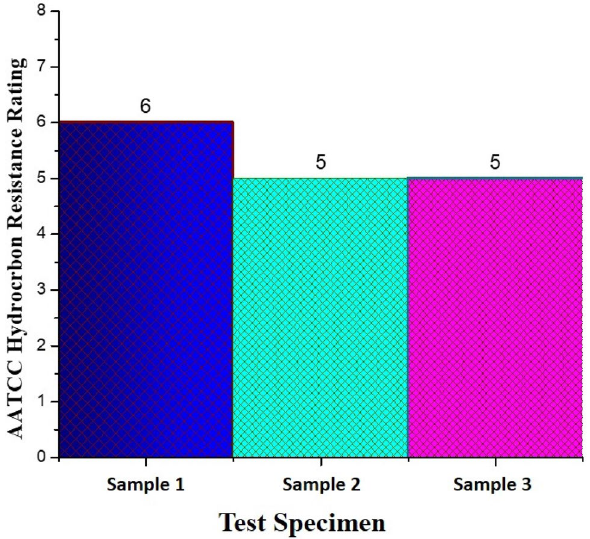
Fig. 19 AATCC 118-2013 oil repellency Hydrocarbon resistance test ratings of HDTMS-treated nonwoven cotton